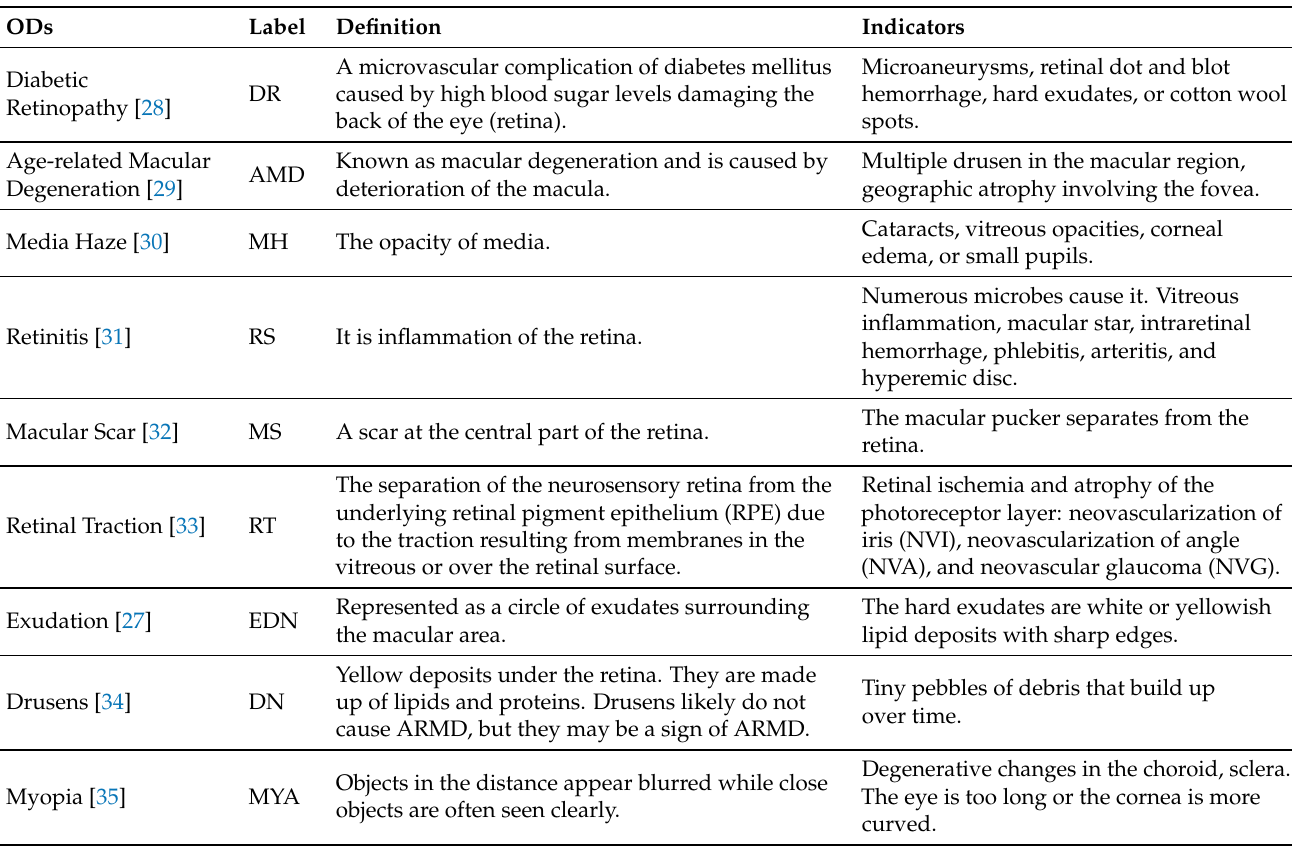
Figure 1. Different retinal color fundus images with different ODs. ( a ) Normal, ( b ) DR, ( c ) RT, ( d ) MH and MS, ( e ) MH and DN, ( f ) MH, MYA, and ODC, ( g ) DR, LS, and TV, and ( h ) EDN, ODP, and TSLN. Table 1. Different ODs with their labels, definitions, and